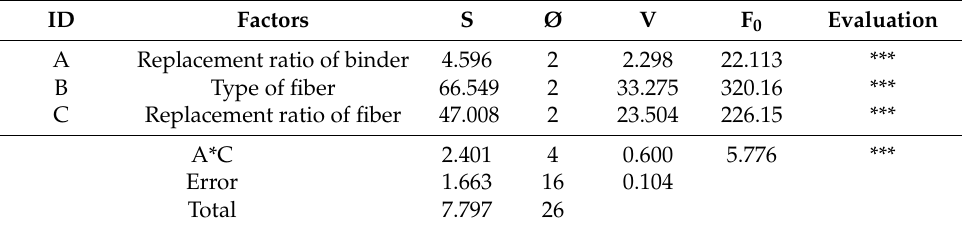
Table 12. Variance analysis for the flexural strength of the extrusion panel.